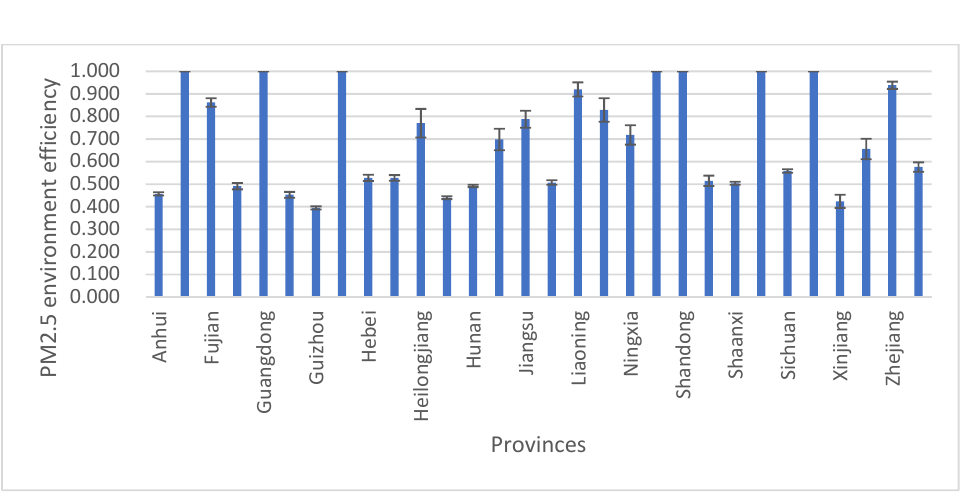
Figure 2. The average environmental efficiency score for each province.